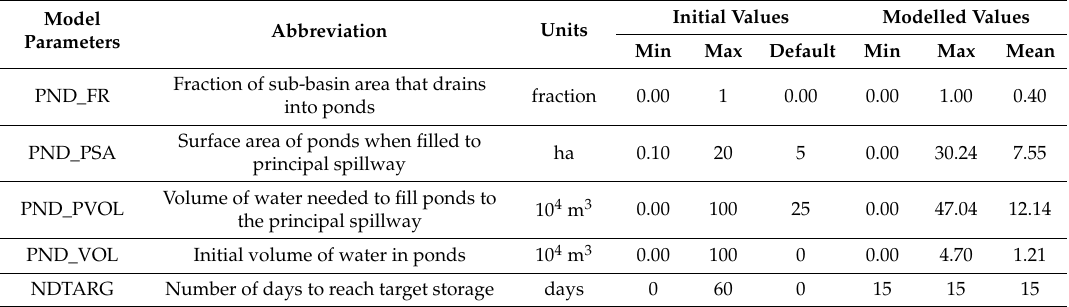
Table 1. Farm dams input with initial and modelled values in